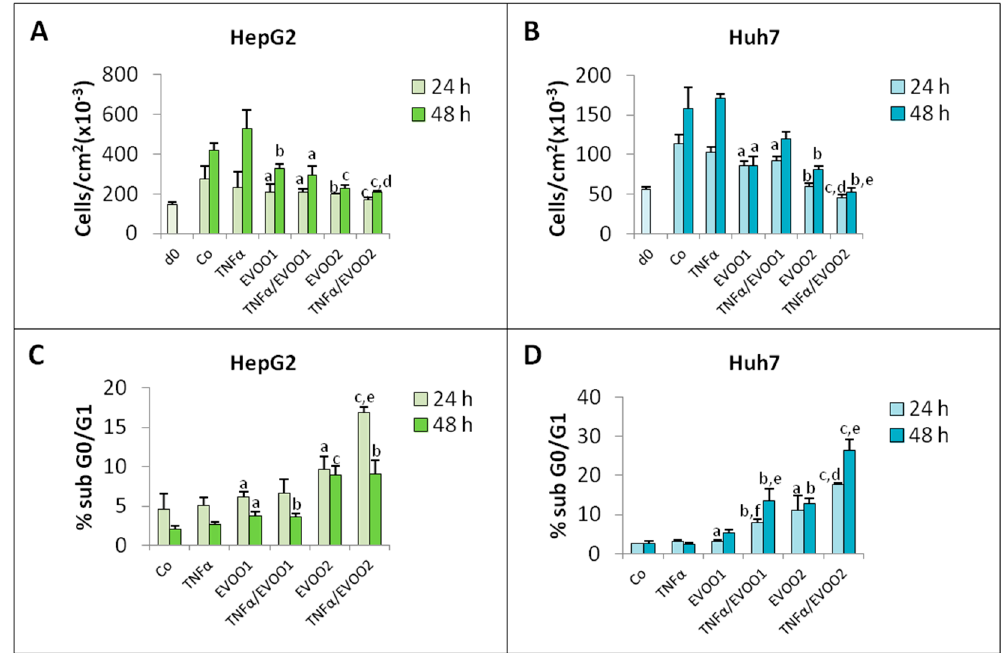
Figure 8. TNF α potentiates the cytotoxicity of EVOO phenolic extract. The cells were incubated for 24 and 48 h with two different doses of the phenolic extract in the presence or absence of TNF α . ( A , C ) Growth curve and percentage of sub G0/G1 of HepG2 cell line. ( B , D ) Growth curve and percentage of sub G0/G1 of Huh7 cell line. The results are representative of three experiments. Data are presented as mean ± SD. (a: p < 0.05, b: p < 0.01, c: p < 0.001 versus Control; d: p < 0.05, e: p < 0.01, f: p < 0.001 versus EVOO).